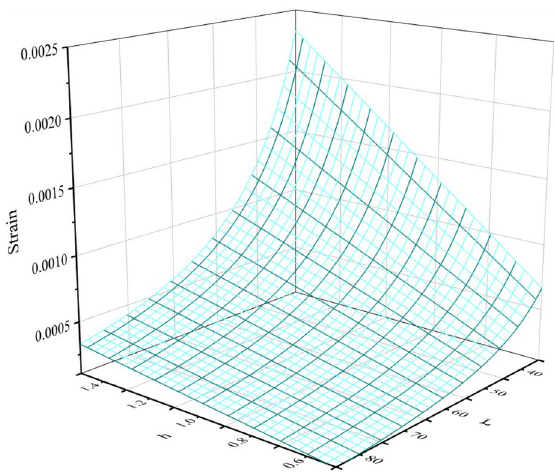
Figure 6. 3D diagram of the relationship between the size of cantilever beam and strain (The figure was generated by Origin 2016 × 64 (https:// www. origi nlab. com/